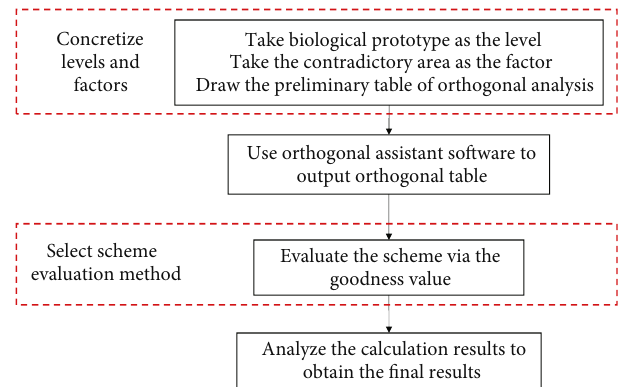
Figure 4: The fl owchart of the selection of the optimal biological prototype combination via orthogonal